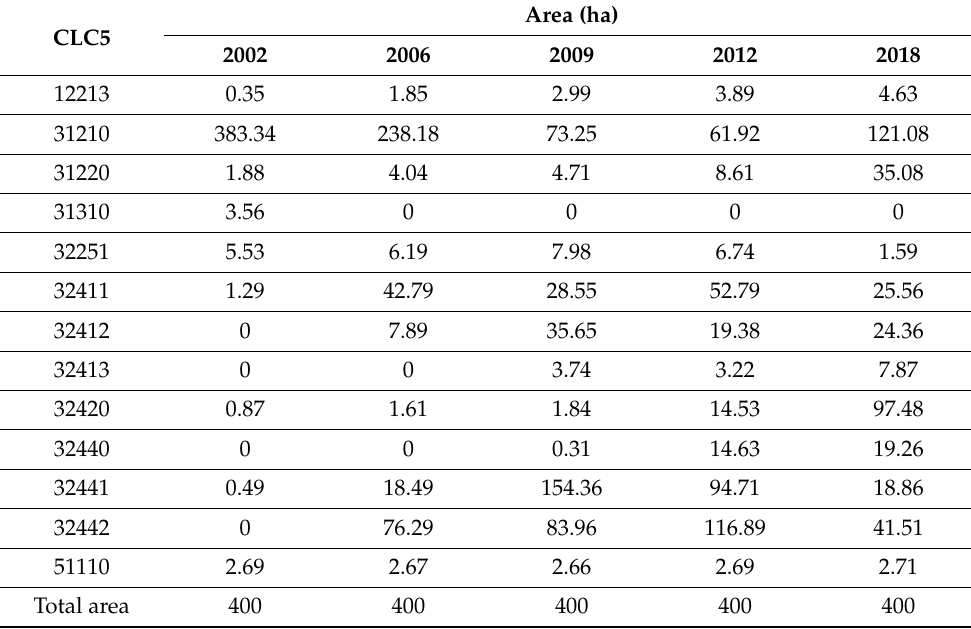
Table 5. Land cover development of area NW from Tatransk á Lomnica (TANAP) in 2002–2019.